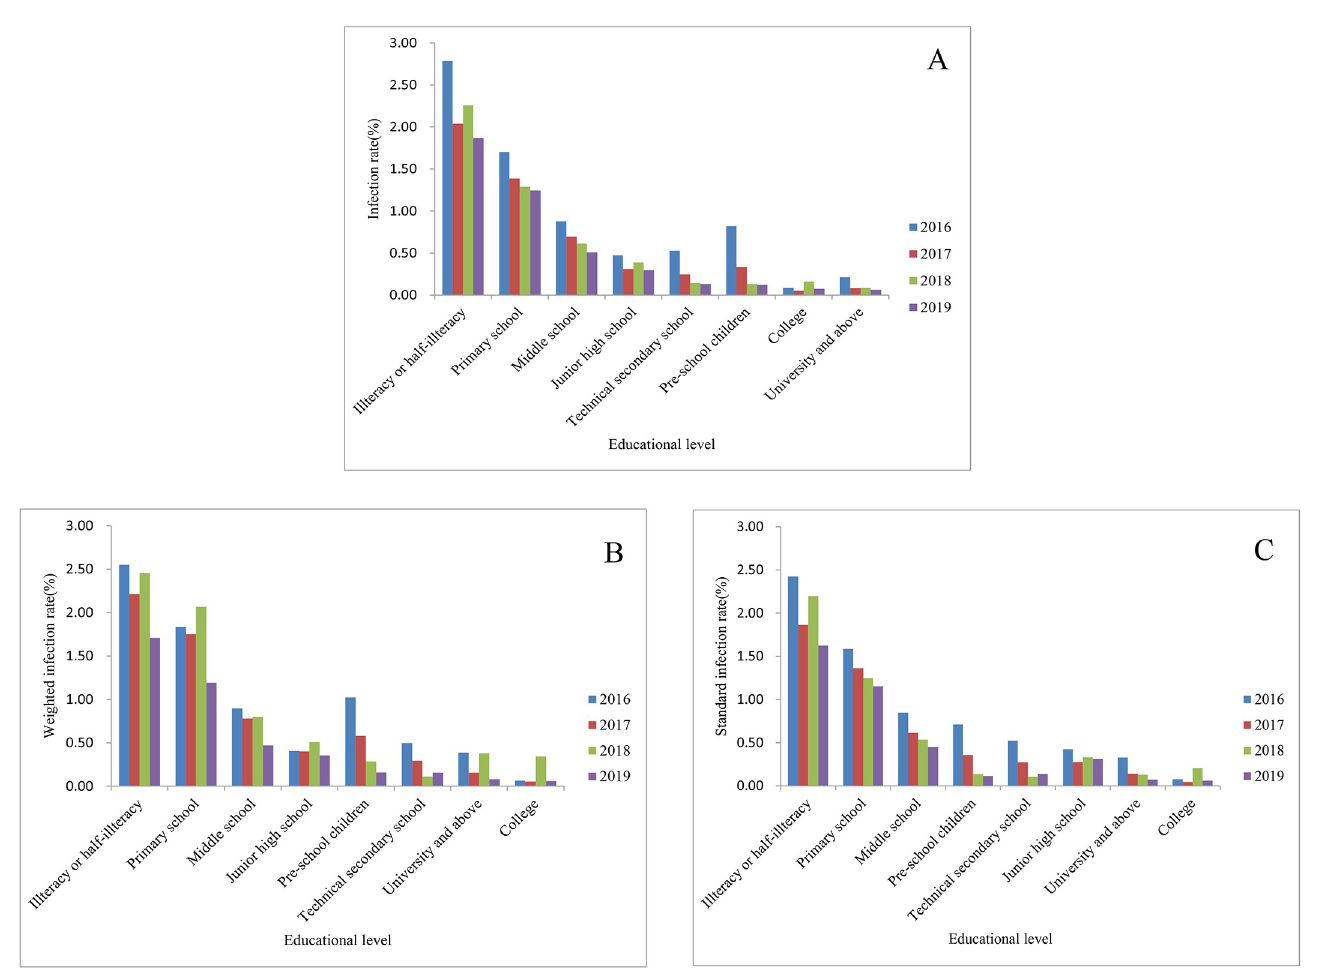
Fig 6. Educational distribution of hookworm infections from 2016 to 2019 according to the national surveillance. A. Infection rate; B. Weighted infection rate; C. Standard infection rate.